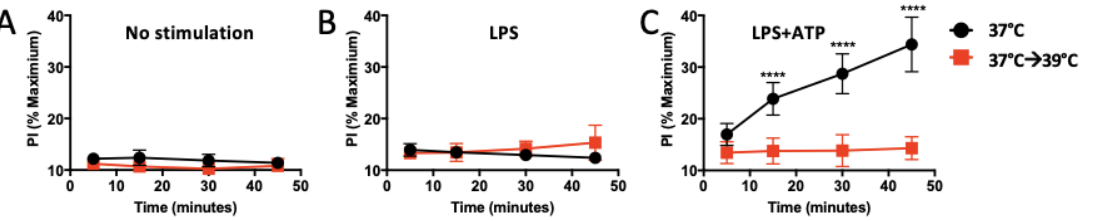
Figure 2. Mild heat shock inhibits membrane permeability. ( A ) unstimulated controls show no increased permeability: iBMMs were incubated at 37 ◦ C (black circles) or exposed to 39 ◦ C for one hour (red squares) followed by addition of PI (5 µ M) to assay membrane permeability over time. ( B ) LPS controls show no increased permeability: iBMMs were primed with LPS and incubated at 37 °C for the entire 4 hours (black circles) or switched to 39 °C for the last hour (red squares), followed by addition of PI. ( C ) LPS+ATP stimulation shows that exposure to 39 °C inhibits ATP-induced pore formation in the membrane in LPS-primed cells: iBMMs were primed with LPS and incubated at 37 °C for the entire 4 hours (black circles) or switched to 39 °C for the last hour (red squares), followed by addition of ATP + PI The results are representative of two independent experiments. **** p < 0.0001 as determined by a two-way ANOVA with Tukey’s multicorrection comparison.